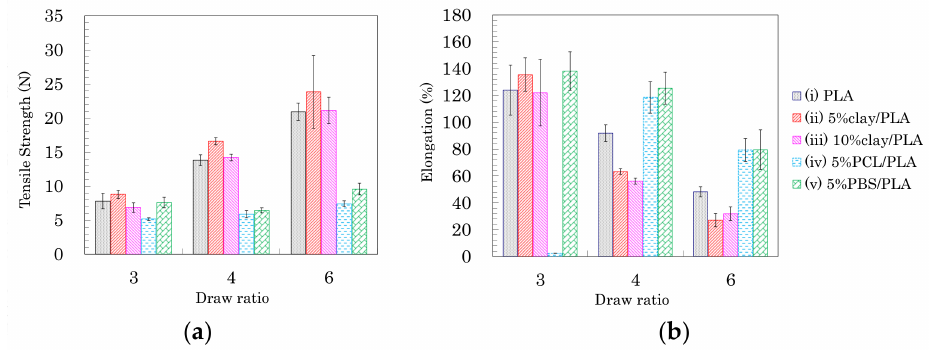
Figure 8. Tensile strength ( a ) and elongation ( b ) of PLA fibers formed using different draw